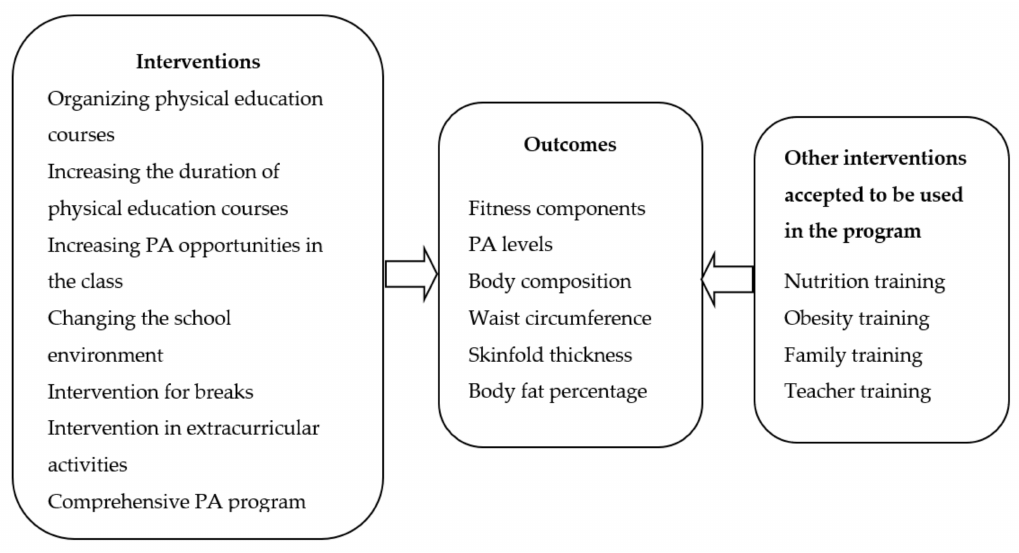
Figure 1. General framework of the systematic review. PA: Physical